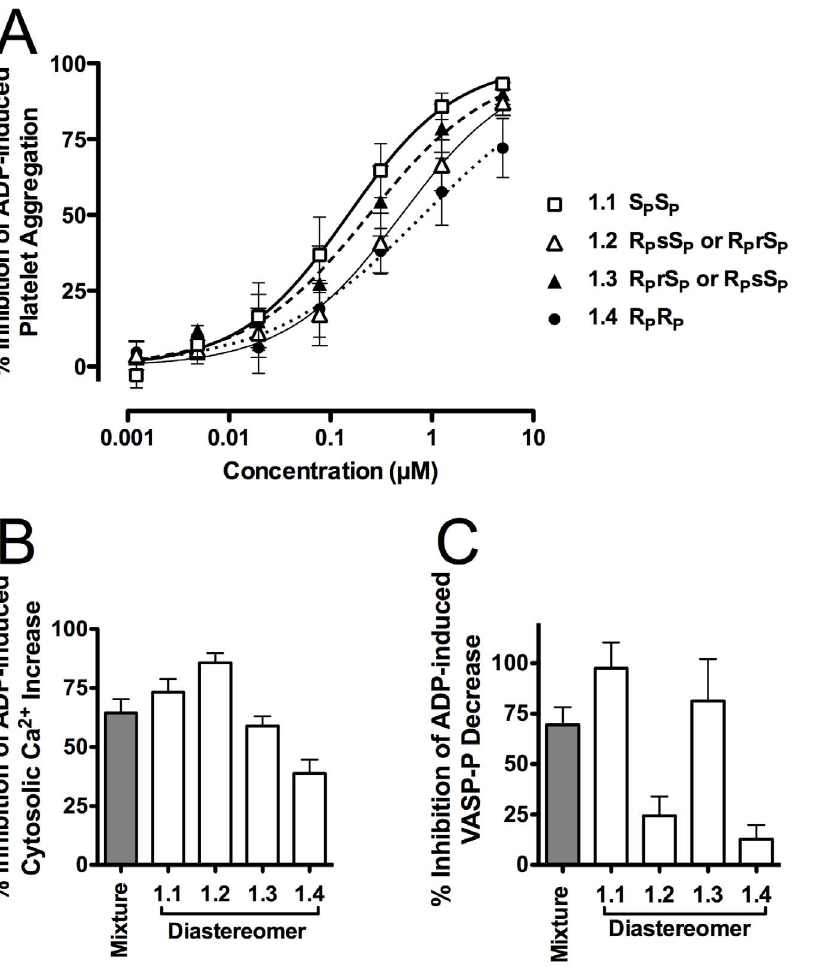
Figure 4. Effects of compound 1 diastereomers on platelet aggregation and platelet ADP receptor signaling. Inhibition by the diastereomers of compound 1 of: A, 3 m M ADP-stimulated platelet aggregation; B, P2Y 12 mediated ADP-induced decrease of VASP phosphorylation; and C, P2Y 1 -mediated ADP-induced intraplatelet Ca 2 + level increase. VASP, vasodilator-stimulated phosphoprotein. For other abbreviation, see Figure 1. doi:10.1371/journal.pone.0094780.g004 platelet P2Y 1 function (p , 0.05, n= 6, Bonferroni’s multiple Metabolism in human plasma comparison test) while 1.2 and 1.3 did not differ significantly Although compound 1 is very stable in human plasma, by using from 1.1 . The order of potency was 1.2 . 1.1 . 1.3 . 1.4 . very long incubation times we were able to observe clear